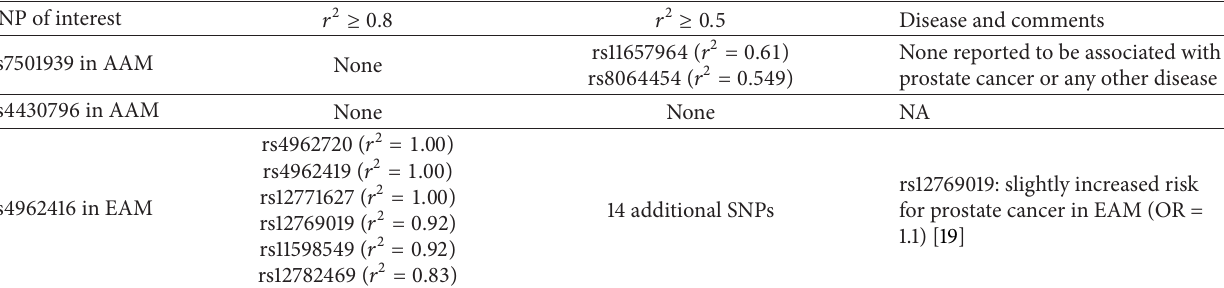
Table 5: SNPs reported to be in LD regions with our SNPs of